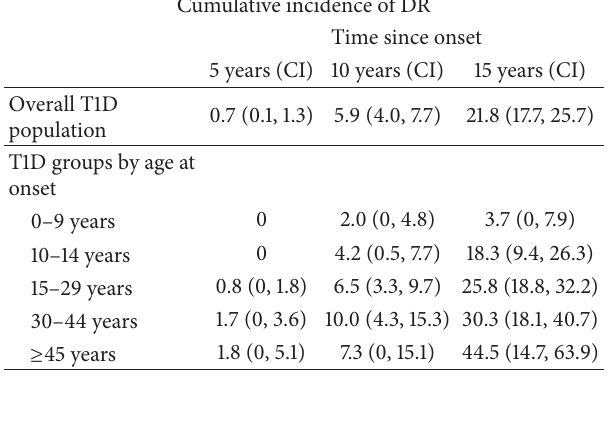
Table 2: Cumulative incidence (IC 95%) after 5, 10, and 15 years since onset.